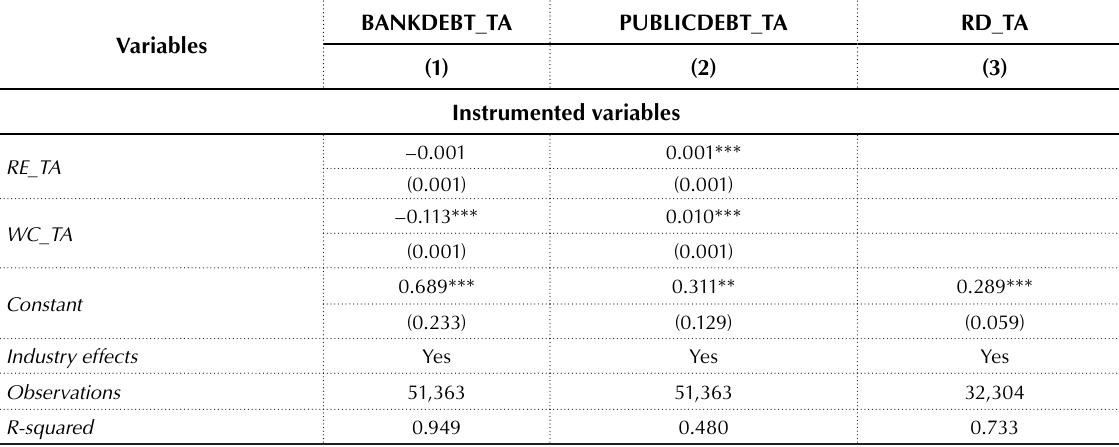
Table 2 (cont.). Hausman test for